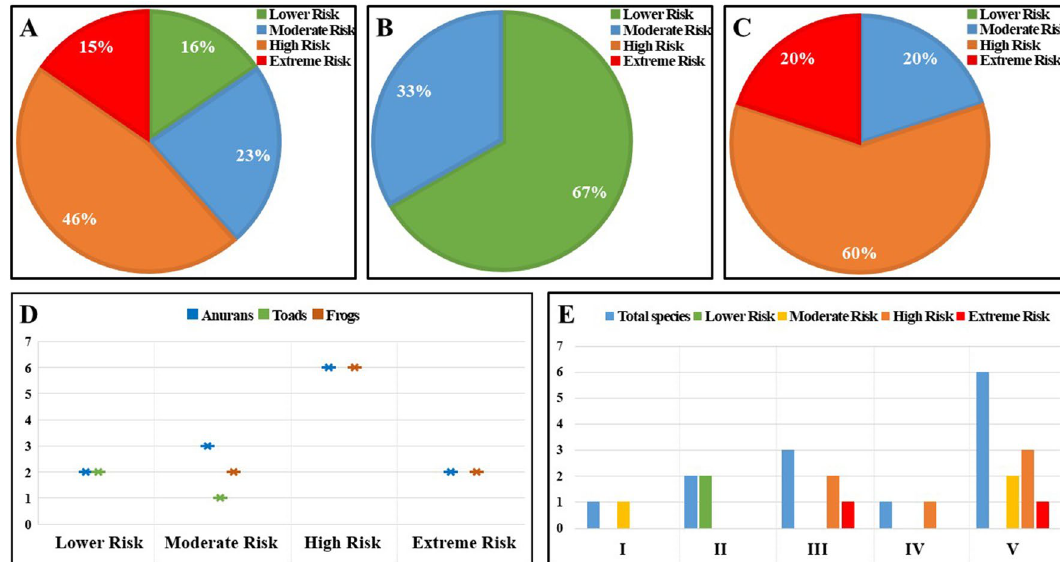
Figure 5. Risk assessment of the anurans of South Korea from the invasion of American bullfrogs-( A ) all anurans, ( B ) toads, ( C ) frogs, ( D ) comparison of anurans by risk categories, and ( E ) comparison of risk statuses of anurans by family. Here, I = Bombinatoridae, II = Bufonidae, III = Hylidae, IV = Microhylidae, and V =